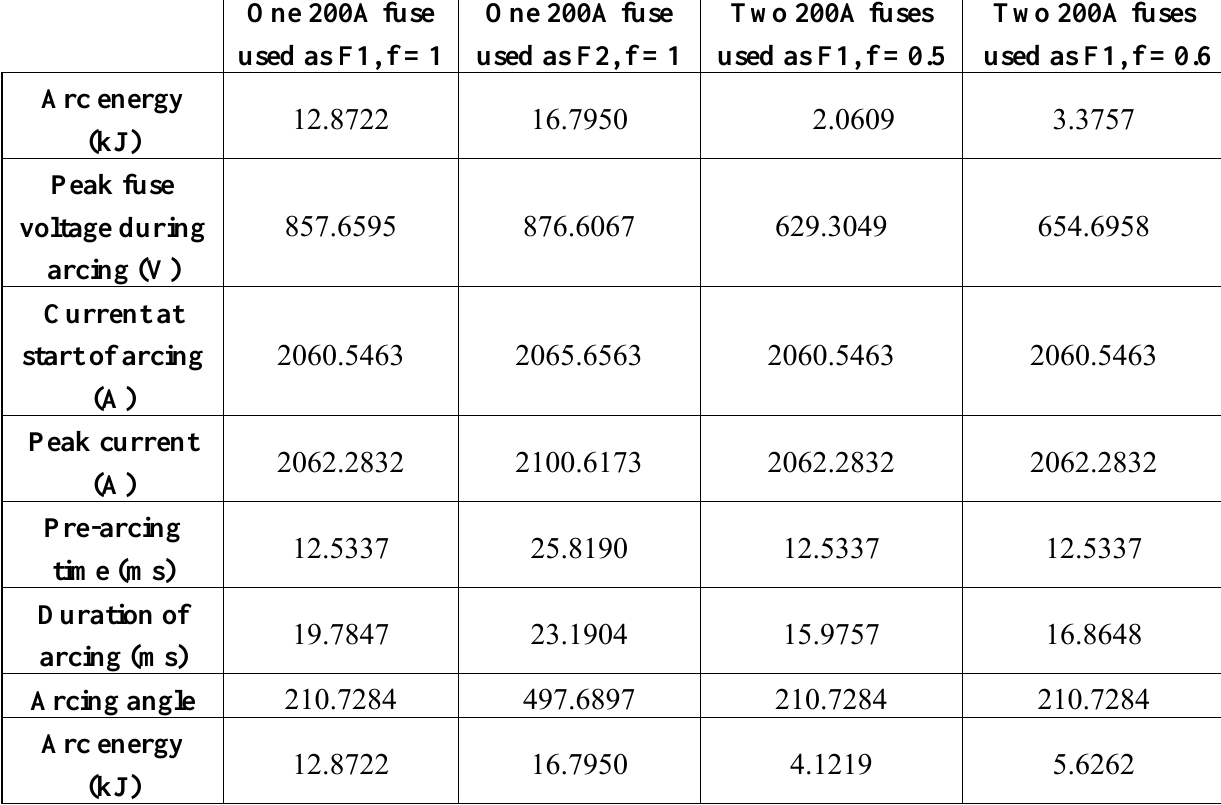
Table 3. Lists the arc energy, peak fuse voltage, current at start of arcing , peak arcing current, pre-arcing time, arcing duration, arc-angle and total arc